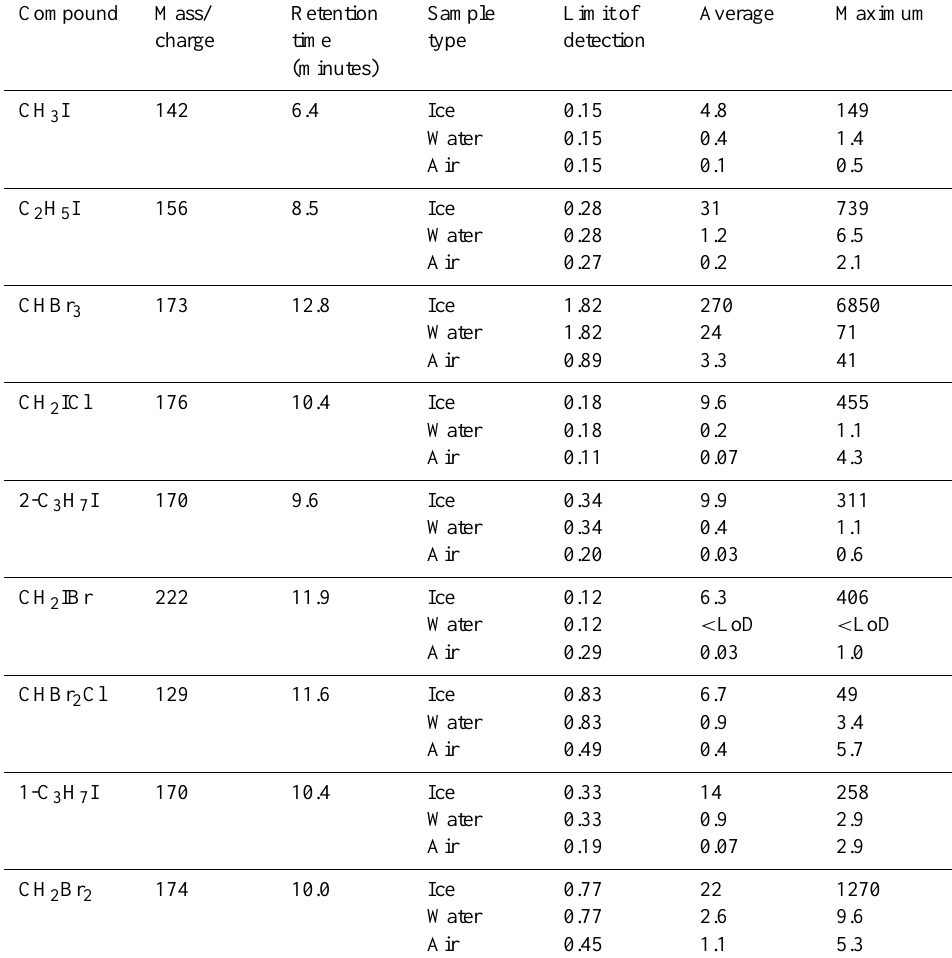
Table 2. Halocarbons measured by GCMS, showing mass/charge ratio, retention time, and limit of detection (LoD). There were 55 ice samples, 37 water samples and 99 air samples. Results for ice and water samples are in pM, results for air samples are in pptv. The LoD result is the LoD at the start of the campaign. Average and maximum values for ice and water samples are normalised to brine volume and rationalised to salinity (see Sect. 3) – for comparison with their LoDs, the observed ice and water results are typically 1/8 the average and maximum results reported